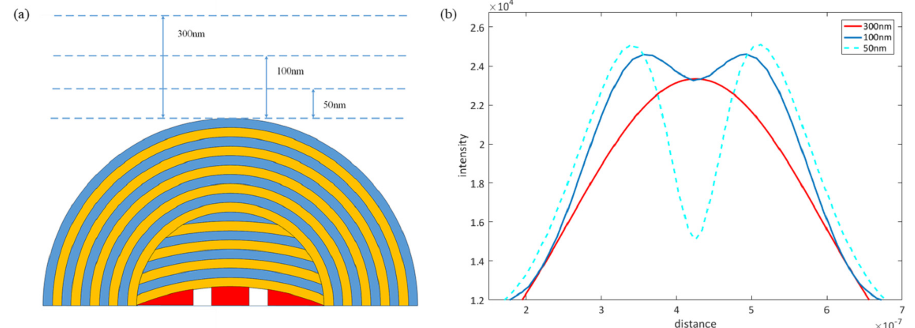
Figure 4. ( a ) Schematic diagram of different detecting distances. ( b ) Intensity distribution detected with different distances. Red line, dark blue line and blue dashed line represent 300 nm, 100 nm, and 50 nm detecting distance, respectively.